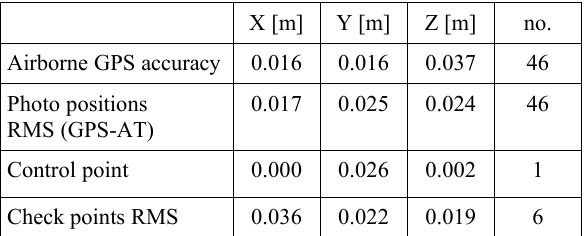
Table 5. Summary of integrated - sensor orientation (AT+GPS+1